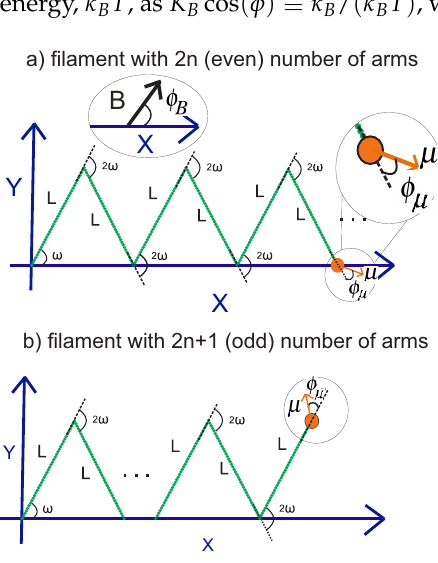
Figure 3. Panel ( a ): The configuration of the grafted kinked filament with an even number of arms with the endpoint attached to a magnetic bead with a magnetic dipole moment in two-dimensional space. Panel ( b ): The configuration of the corresponding system with an odd number of arms. In both panels, there is a constant uniform magnetic field that interacts with the magnetic dipole moment of the magnetic bead. The orientation of the magnetic field relative to the x -axis is denoted by φ B . Further, the orientation of the dipole moment of the magnetic bead relative to the orientation of the endpoint of the structure is denoted by φ µ